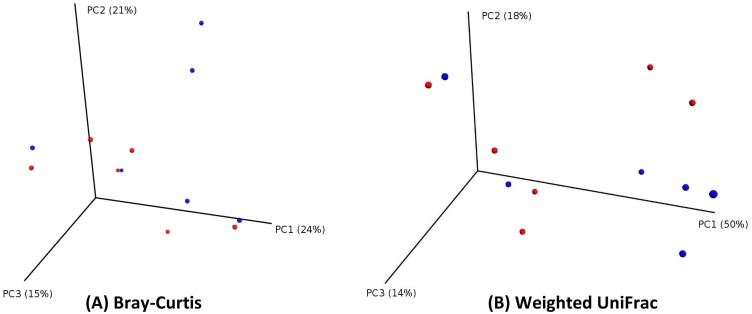
PCoA plots (by sample type).PCoA plots showing less defined clustering of samples, each colored according to the sample type (red for swab; blue for tissue). (PCoA of Bray-Curtis distances on the left; PCoA of Weighted UniFrac distances on the right).